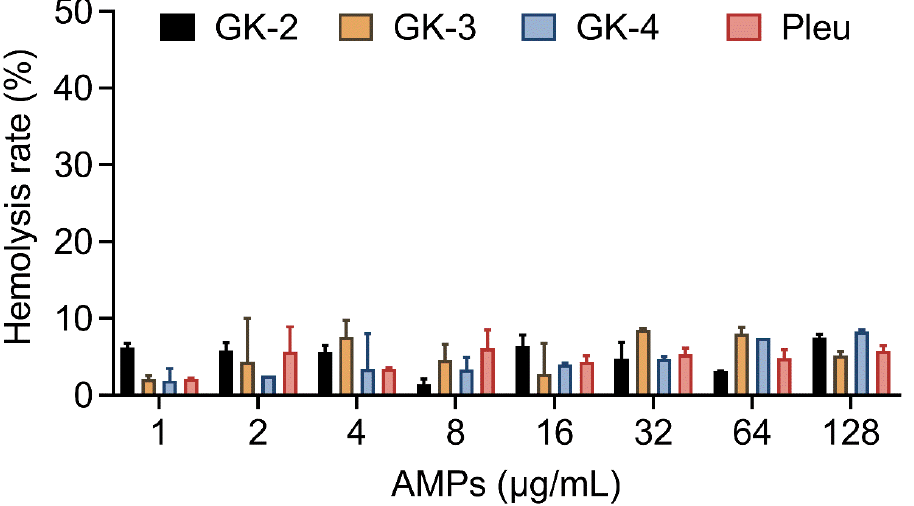
Figure 3. Hemolytic activity of Pleu and its modified peptides against sheep red blood cells (RBCs). Sterilized PBS and ddH 2 O were used as negative control and positive control, respectively.